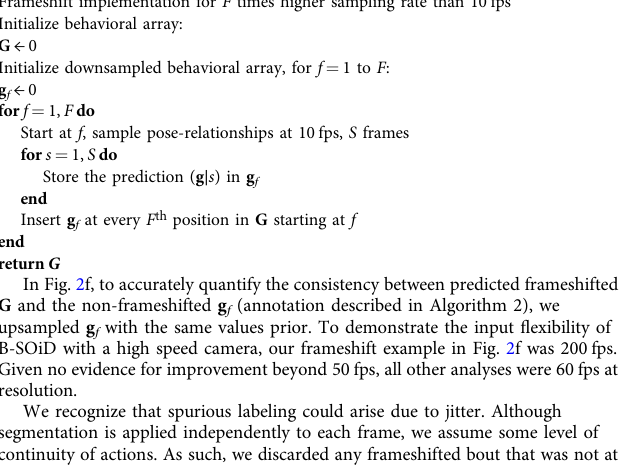
Algorithm 2 Frameshift implementation for F times higher sampling rate than